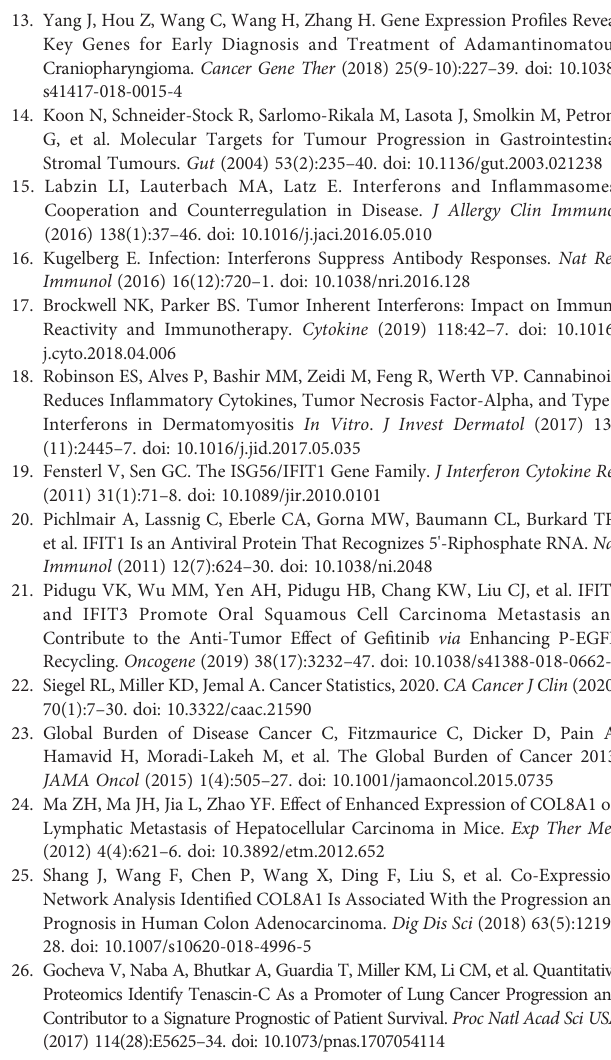
Supplementary Figure 1 | Knockdown of COL8A1 suppresses NSCLC cell line progression. (A) Knockdown ef fi ciency of lentivirus-mediated COL8A1-knockdown in H1299 cells determined by western blot assay. (B) Cell proliferation curves generated using cell viability assays in H1299 cells. (C) Representative image of the results of colony formation assays, showing crystal violet staining. (D) Cell cycle analysis examined by fl ow cytometry. (E) Cell apoptosis assays of H1299 cells. (F) Cell migration and invasion capacity of COL8A1-silenced NSCLC cells determined by transwell assays of H1299 cells. *p < 0.05, **p < 0.01, ***p <